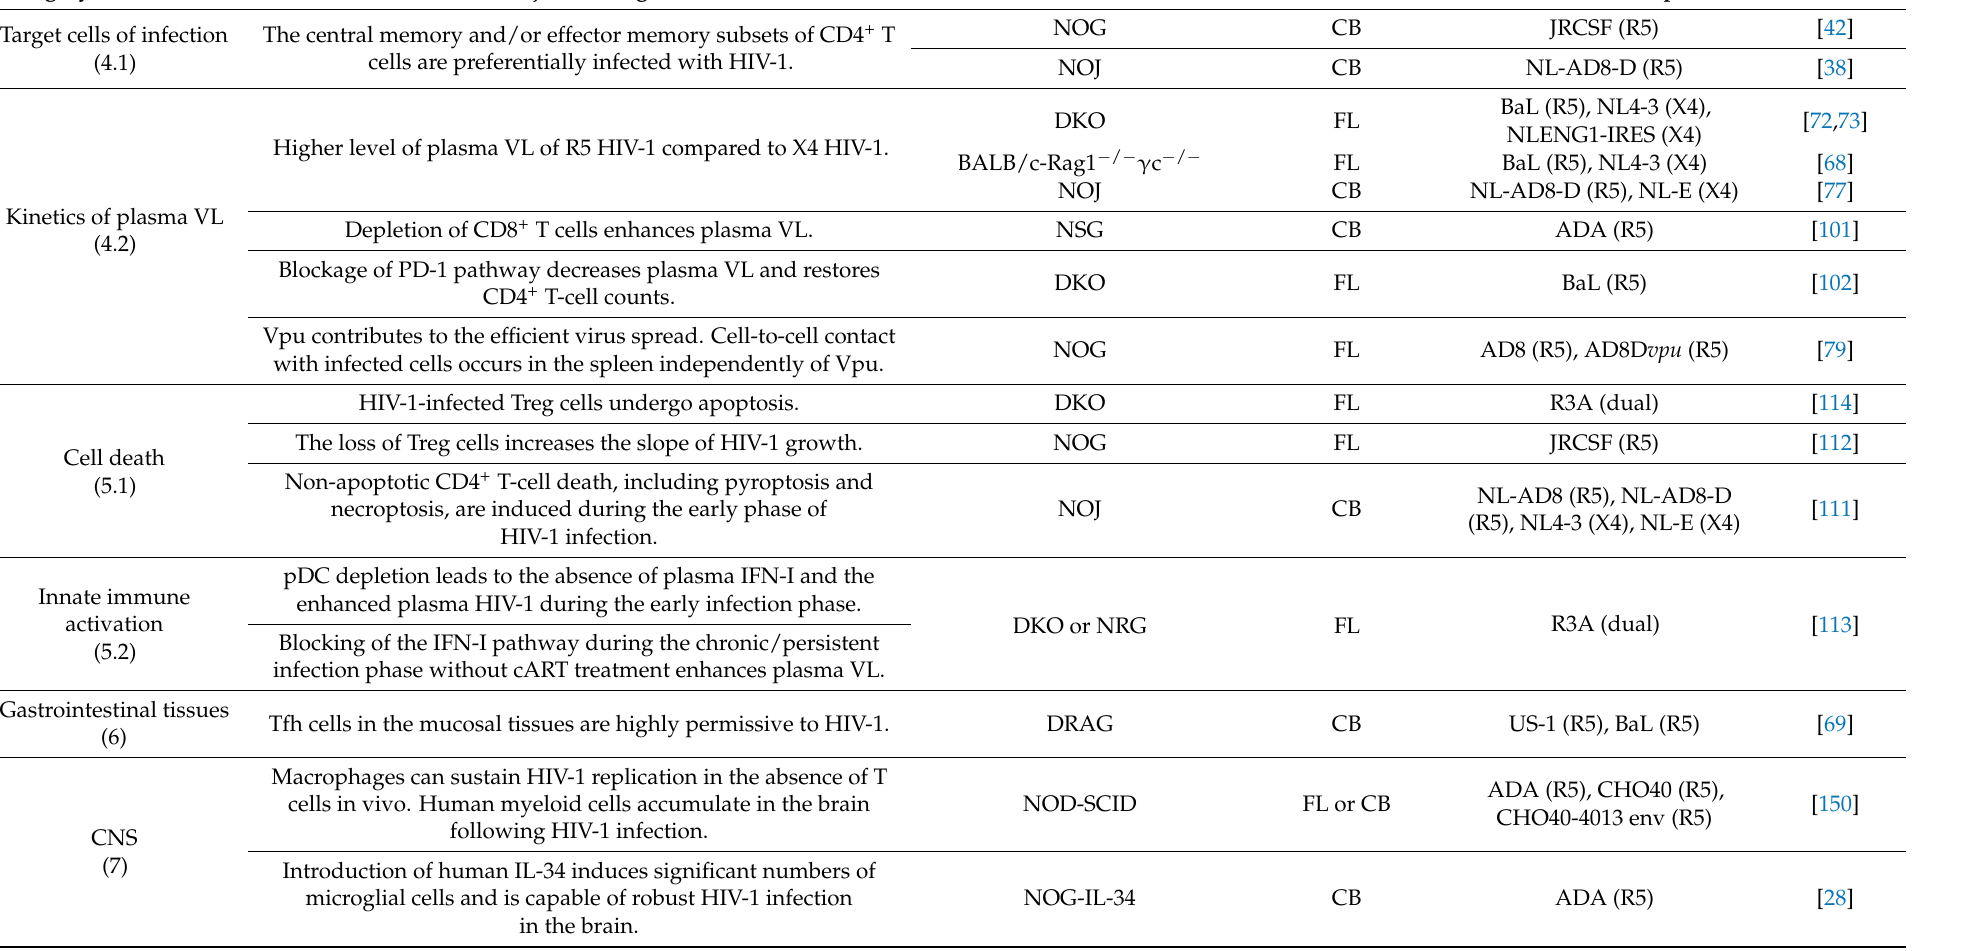
Table 2. Summary of major findings of HIV-1 pathogenesis and therapy using non-BLT mice cited in this review. Category (Section